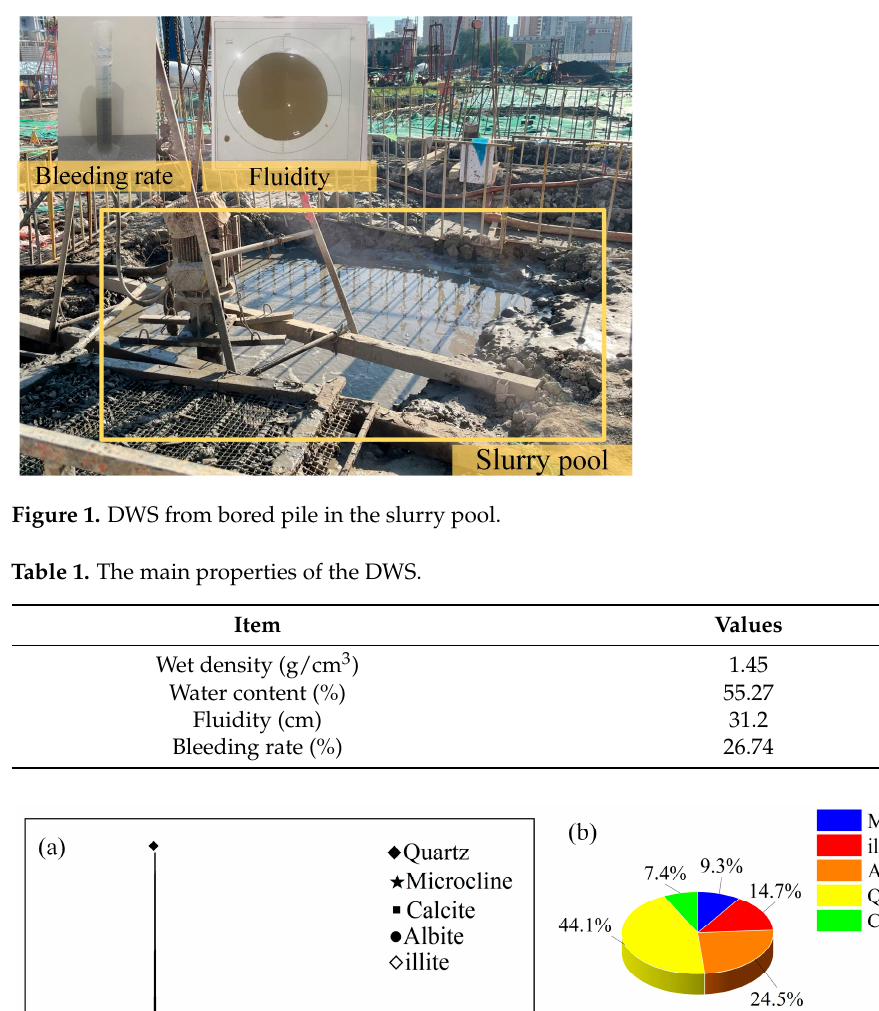
Figure 2. XRD and XRF analyses of DWS. ( a ) XRD spectra. ( b ) The mass fractions of ingredients. ( c ) The mass fractions of elements (Wt%).